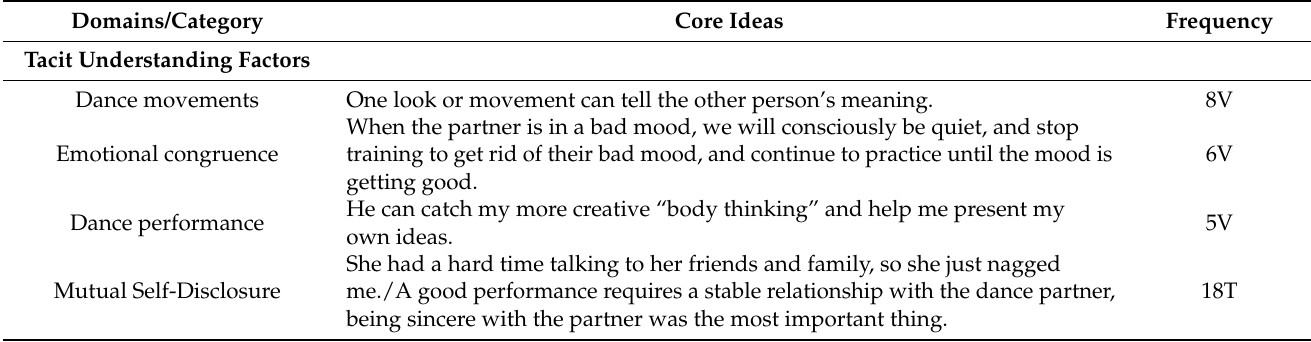
Domains/Category Tacit Understanding Factors Dance